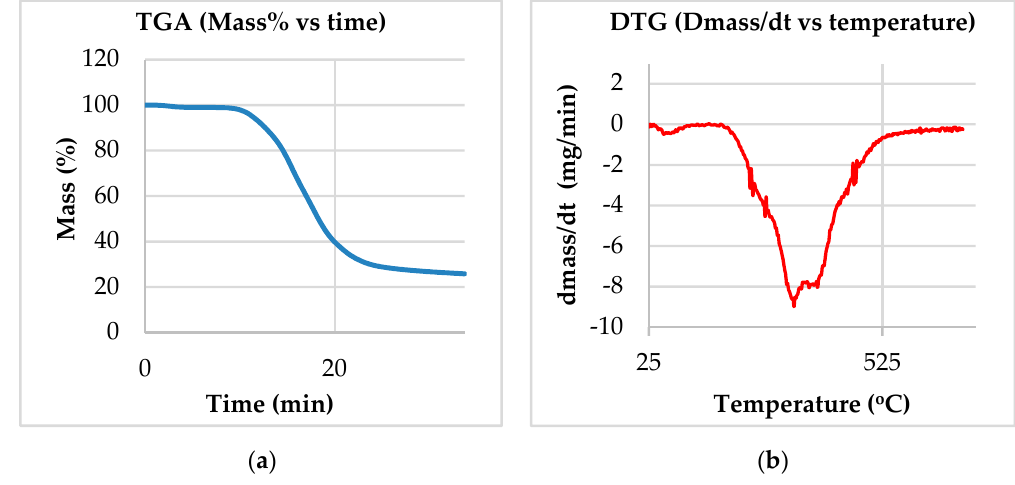
Figure 7. ( a ) Pretreated peach seeds weight loss diagram as a function of time (TGA, N 2 flow). ( b ) Pretreated peach seeds weight change rate diagram as a function of temperature (DTG, N 2 flow).